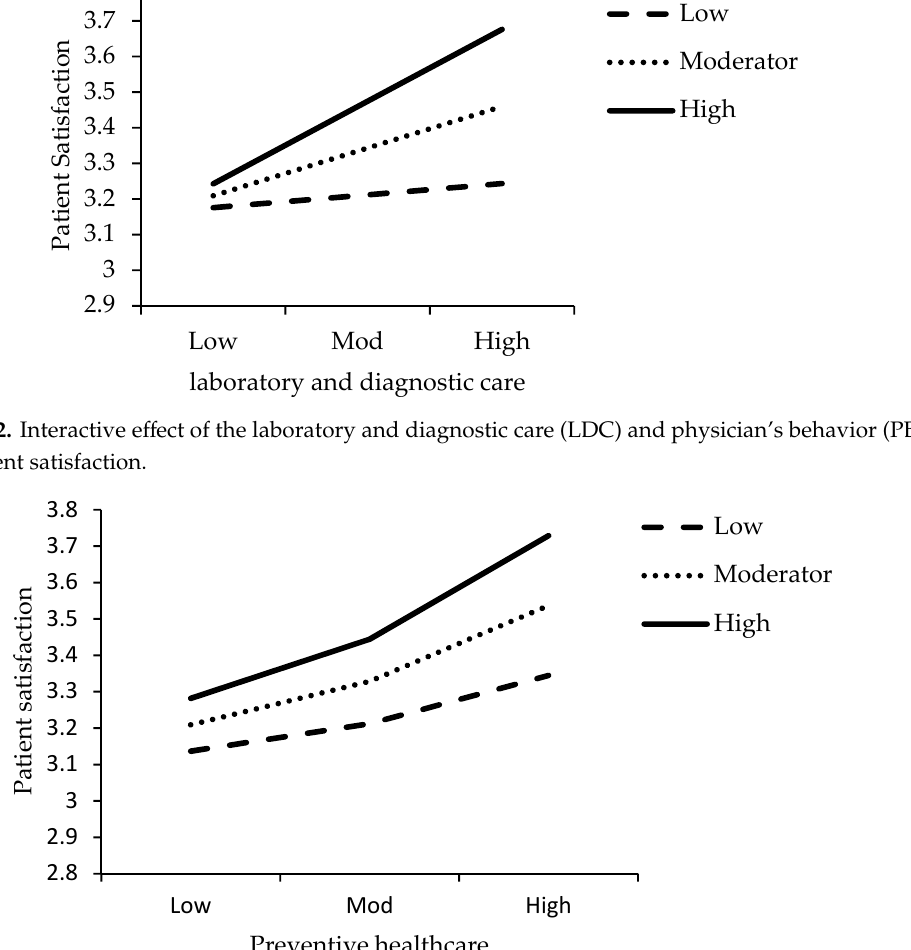
Figure 3. Interactive effect of the preventive healthcare (PHC) and PB on patient satisfaction.